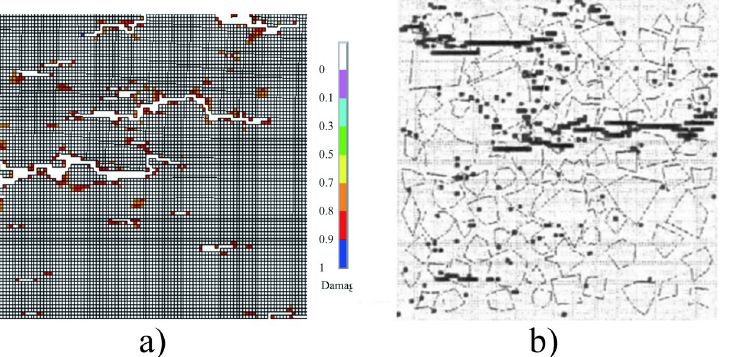
Fig 12. Failure modes of concrete under uniaxial tension. a) The numerical result obtained from the FE model in Fig 9. b) The result given in the literature [33].